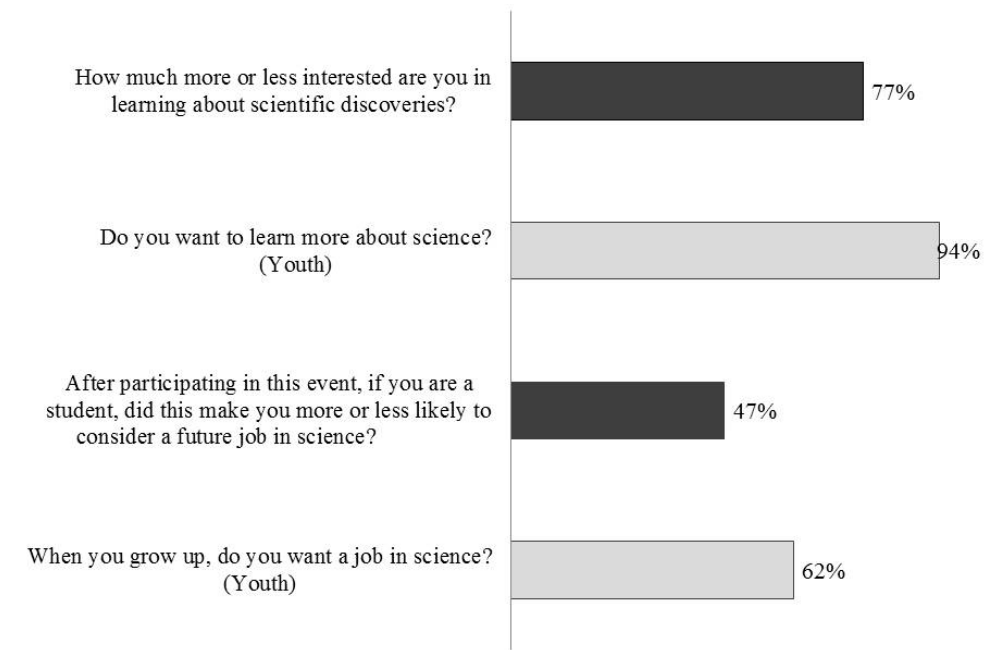
Figure 8. In most cases, the majority of adults and youth reported an increased interest in science and science-related careers as indicated by adult/family (dark bars) responses and youth responses (light bars) to relevant questions. The adult/family questions (top and third down) show the combined adult responses from “much more likely” and “more likely”. The two youth questions (2nd down and bottom) show the proportion of youth responding “yes”. Data included are from BP, UNSM 2014, DMNS, and TZ.